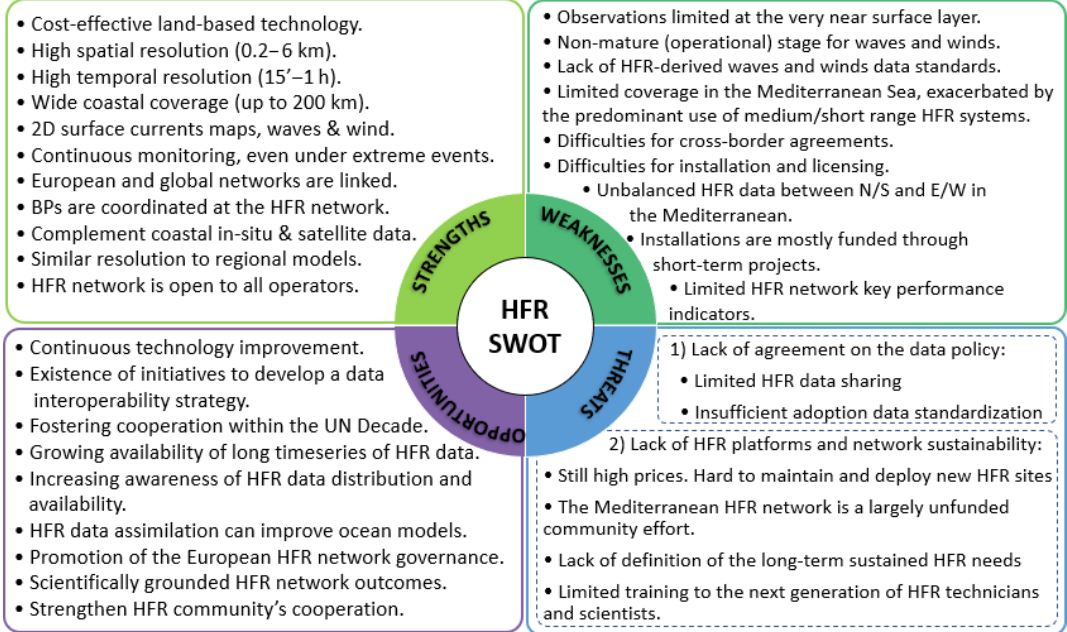
Figure 11. SWOT (strengths, weaknesses, opportunities, and threats) analysis of the Mediterranean HFR